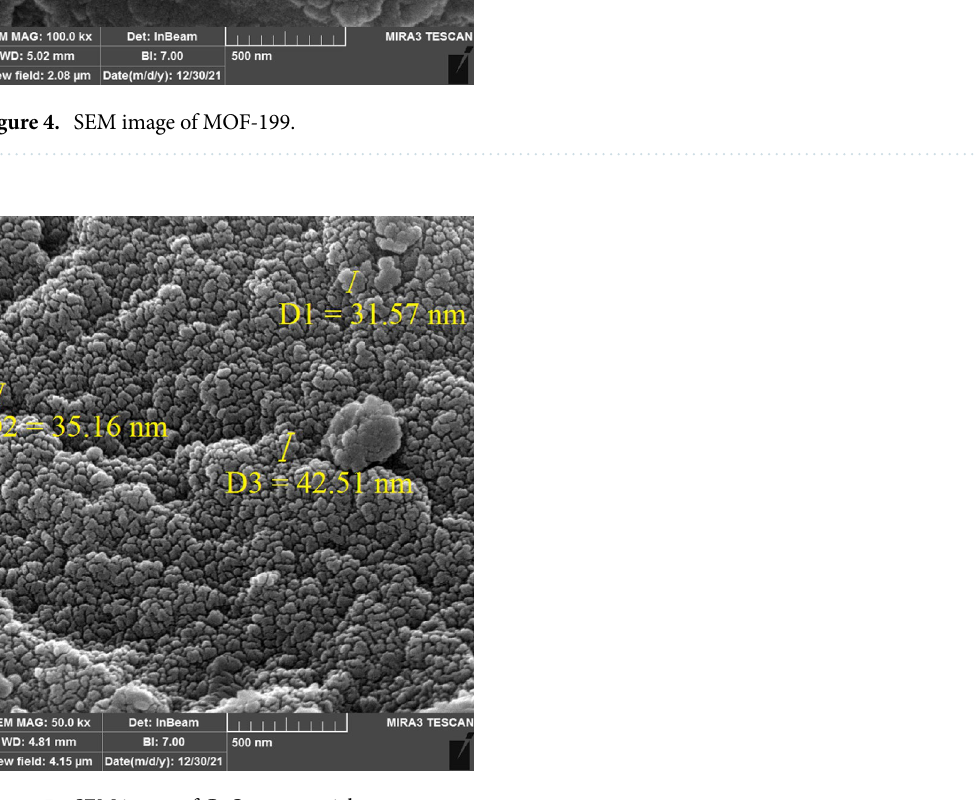
Figure 5. SEM image of CuO